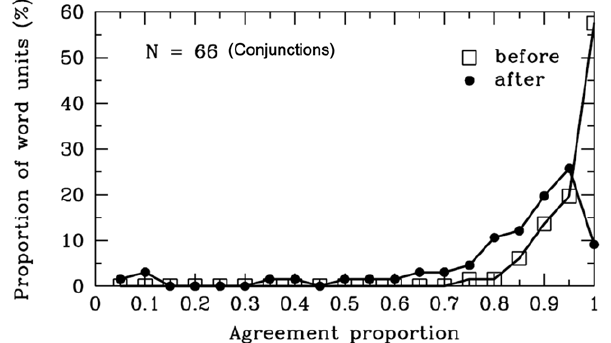
Figure 4. Adverbs. Frequency distribution of agreement proportions for word boundaries before (open squares) and after (filled circles) the adverbs. The y-axis represents the proportion of SWU. The number of SWU is also present in the figure.